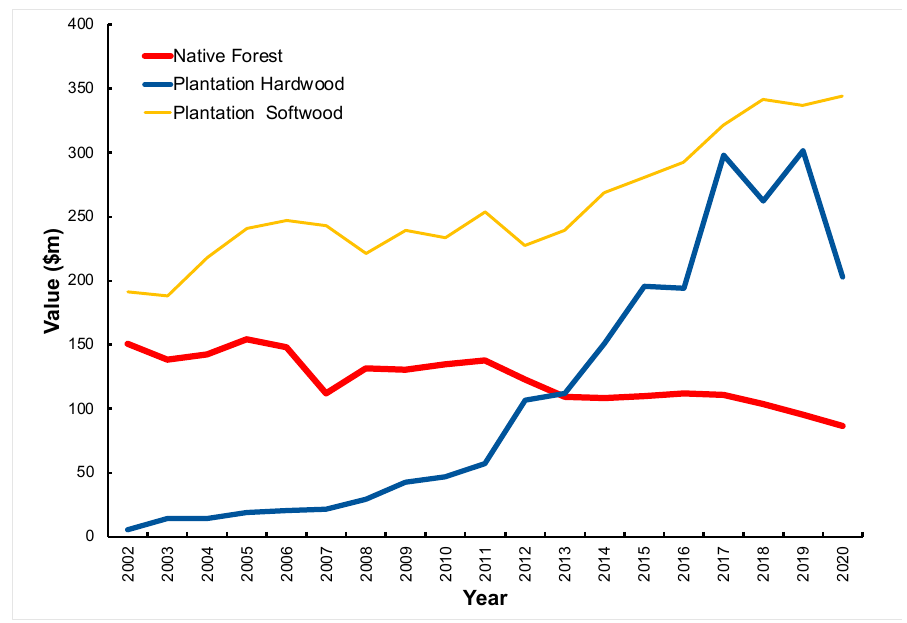
Figure 6. Value comparison between logs extracted from native forests, hardwood and softwood plantations (derived from ABARES 2021 data).